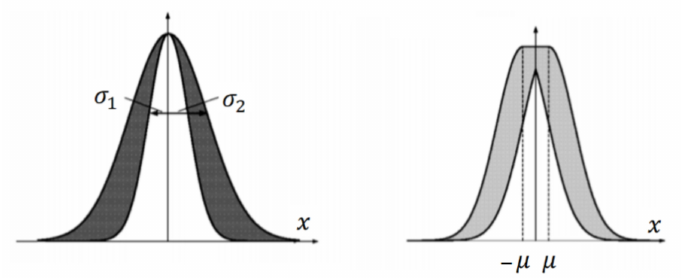
Figure 2. FOU of symmetrical interval types of type-2 fuzzy numbers.